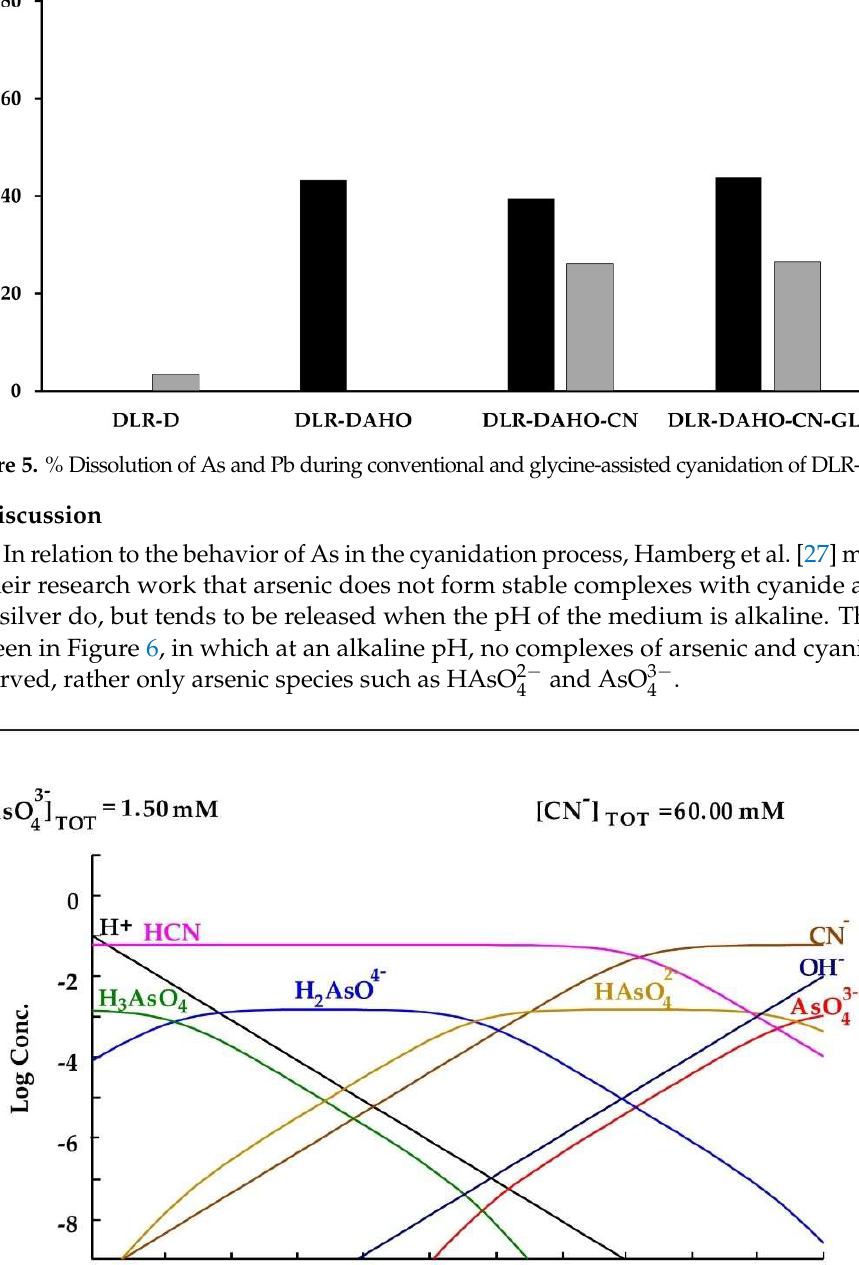
Figure 7. Diagram of distribution of species of the Pb 2+ -CN − system based on the concentrations present in the leaching medium. Diagram made by the authors in Medusa software version 2010.